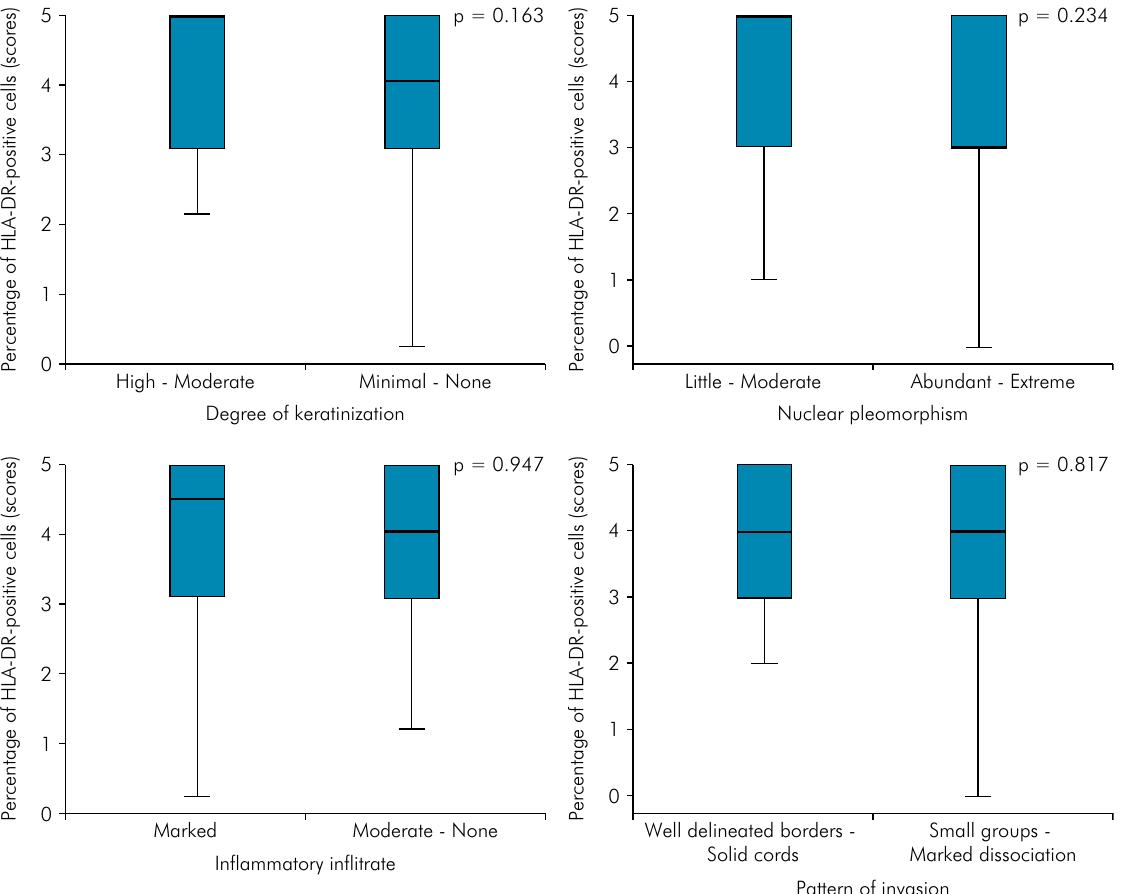
Figure 3. Box plot charts illustrating the scores of HLA-DR-positive cells in LLSCC according to degree of keratinization, nuclear pleomorphism, pattern of invasion, and inflammatory